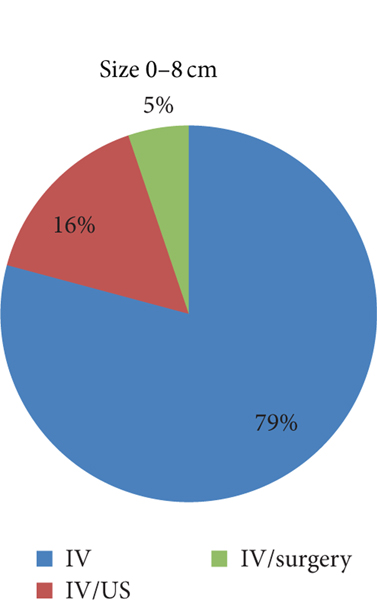
Percentage of each treatment modality used for TOA measuring 0–8 cm.